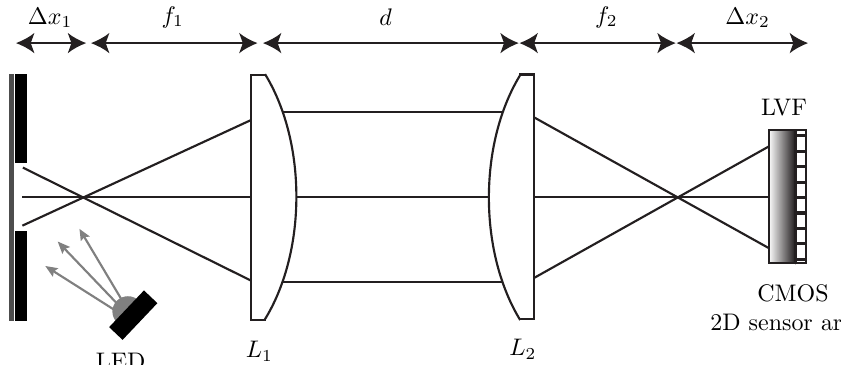
Figure 3. Illustration of the proposed hyperspectral fluorescence spectrometer based on an LVF/CMOS 2D sensor array configuration. In the side view of the measurement setup, the ray path of the fluorescence with the spatial information is shown. The lens adjustment consisting of a plano-convex spherical lens and a plano-convex cylindrical lens images the fluorescent measurement object onto the CMOS 2D sensor array. Due to the imaging through the plano-convex cylindrical lens, this dimension contains the spatial information of the considered measurement